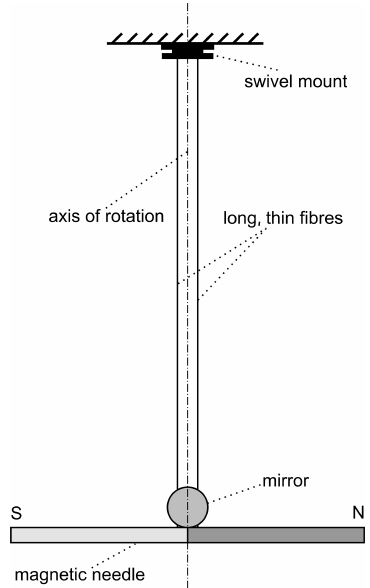
Figure 1. Simplified sketch of a bifilar device (side view).